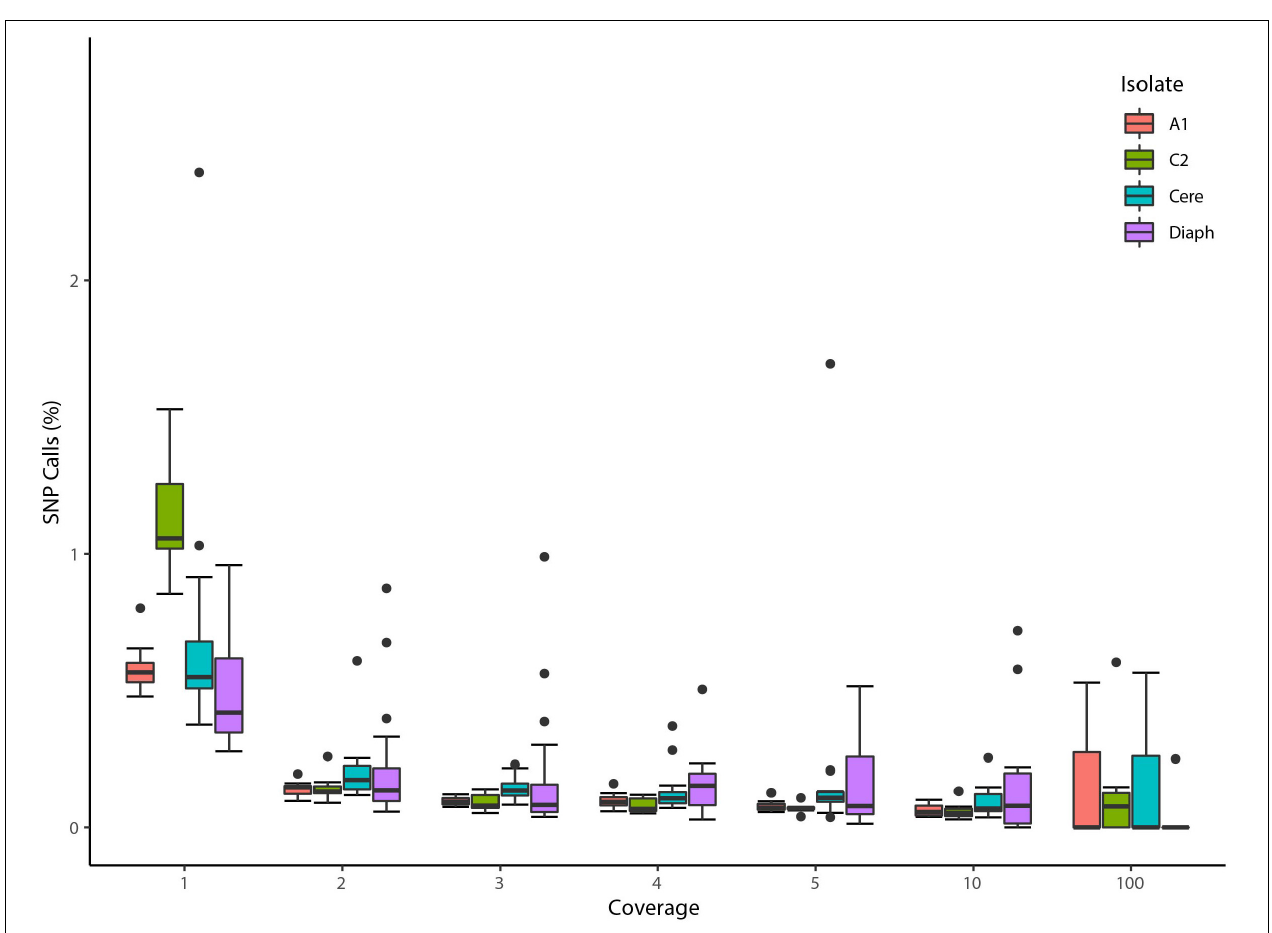
FIGURE 1 | Validation of low coverage depth SNP calls based on single nuclei Illumina reads from four homokaryotic strains. The boxplot represents the percentage of SNPs found to be in disagreement with reference assemblies in two R. irregularis isolates (A1 and C2), R. cerebriforme (Cere), and R. diaphanous (Diaph) organized by the number of reads supporting a given SNP. Boxes represent 25–75% percentile and whiskers represent the largest and smallest value within 1.5 interquartile range above 75th or below 25th percentile. One outlier from R. diaphanus is not shown (SN17, coverage 100: 1 mismatch out of 36